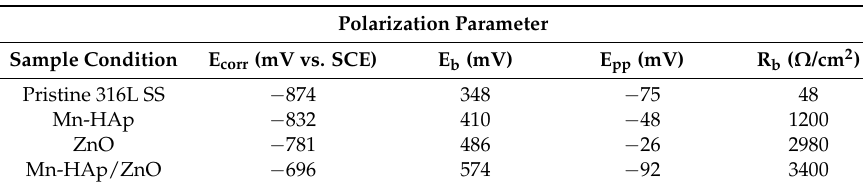
Table 1. Potentiodynamic polarization parameters of pristine 316L SS, and Mn-HAp, ZnO, and Mn-HAp/ZnO bilayer coating on 316L SS. SCE, saturated calomel electrode.